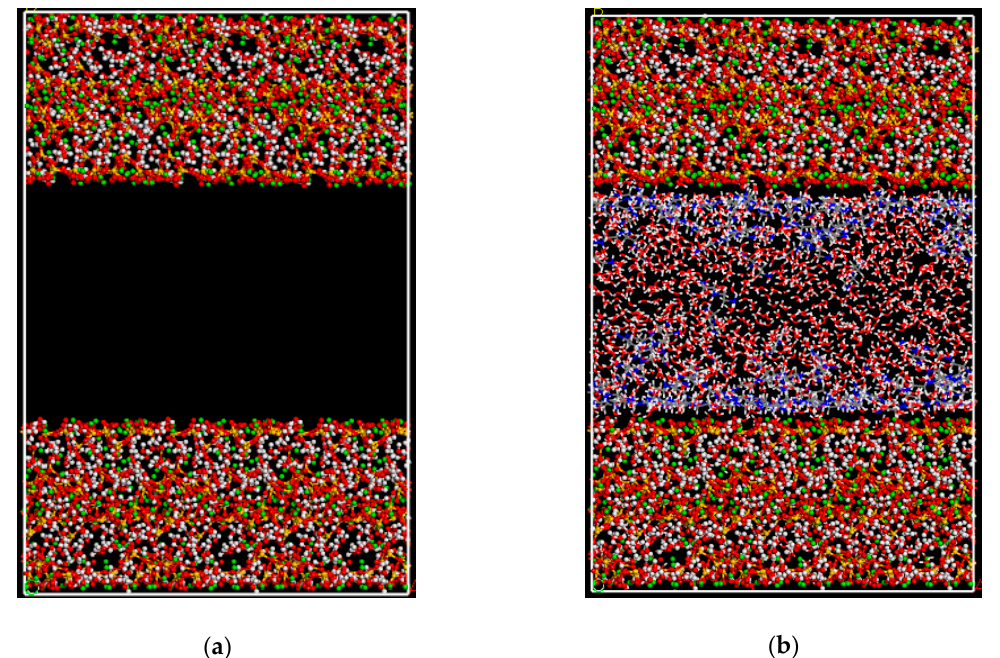
Figure 3. Snapshots for the pore adsorption test (red ball: oxygen atom; green ball: calcium atom; white ball: hydrogen atom; yellow ball: silicate atom; violet ball: sodium atom; blue ball: nitrogen atom; grey ball: carbon atom): ( a ) C-S-H pore. Cell parameters: a = 18.37 Å, b = 26.48 Å, c = 78.72 Å, α , β , γ , equal to 90 ◦ ; ( b ) GCMC adsorption.